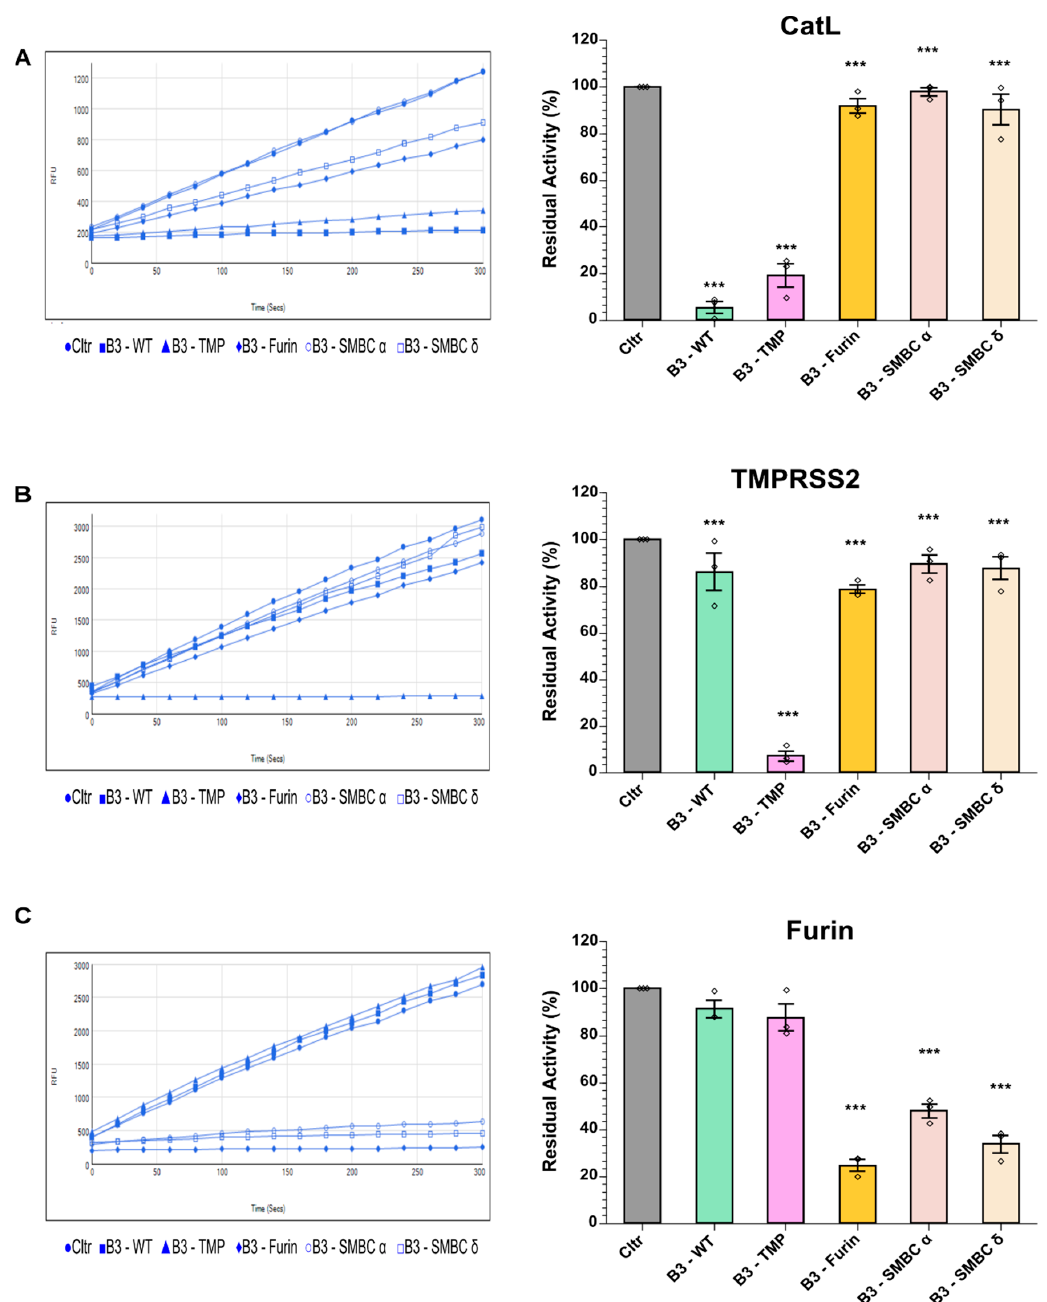
(B3-TMP) having the greatest effect, showing 90% inhibition at 50 µ M, which is comparable to the CM control (Figure 4A).